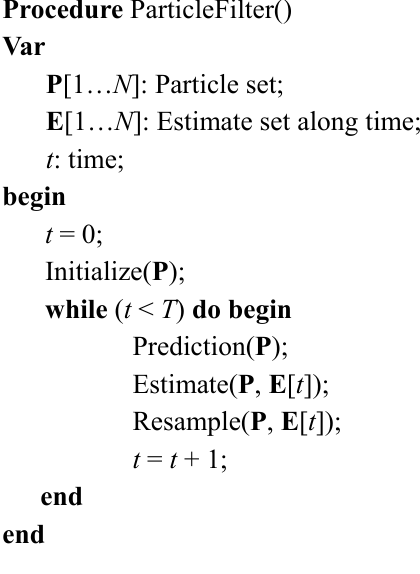
Algorithm 2. A pseudo-code for PSO